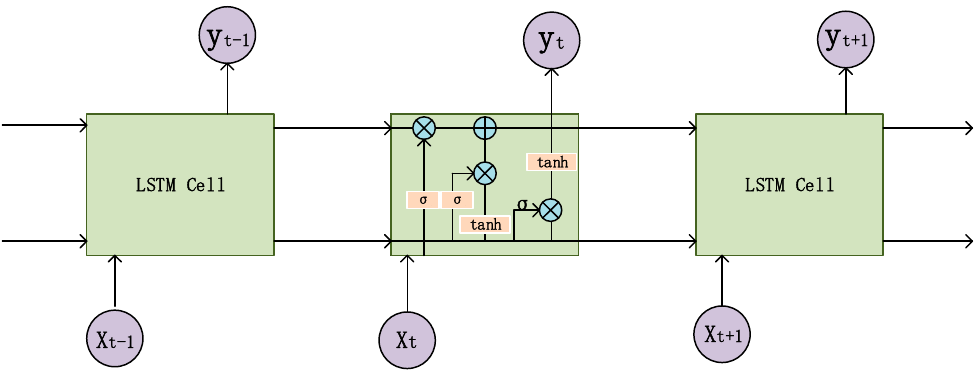
Figure 3. LSTM internal unit structure.